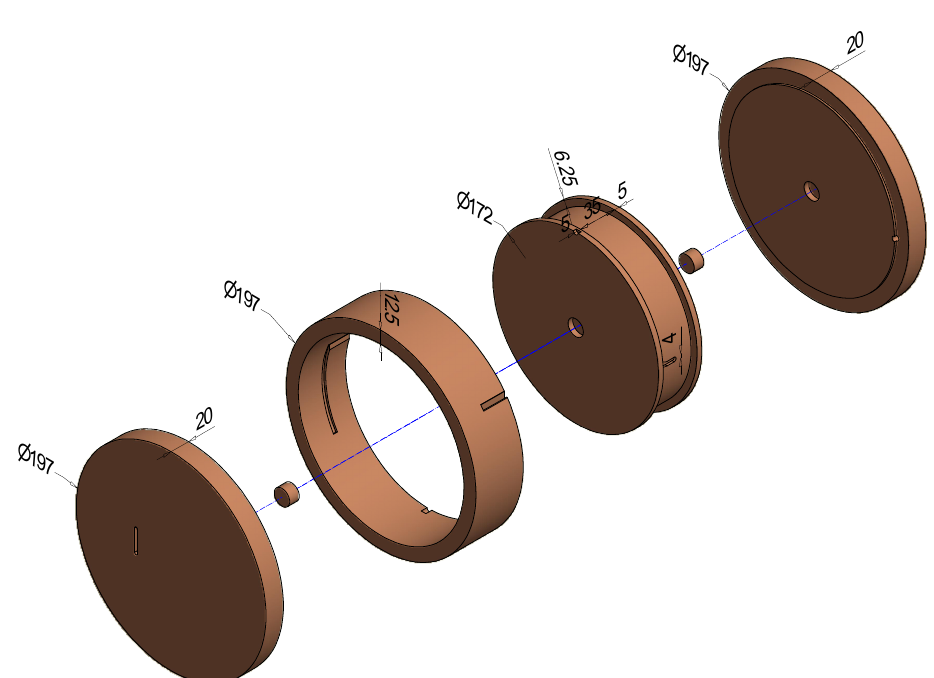
Figure 1. Exploded view of the Solid-Phase Bath (SoPhaB) made from ultrafine copper intended as temperature reference for FODS applications. Its central part, consisting of the inner core and the outer ring, is made from one solid piece of copper by means of electrical discharge machining to create tightly interlocking parts. The total weight of one SoPhaB is approximately 22 kg. All parts and supply materials to construct one pair are listed in Tables A1 and